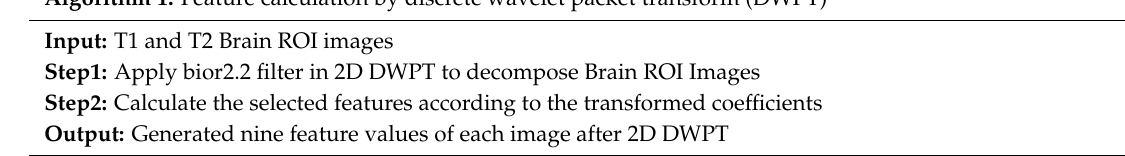
Algorithm 1. Feature calculation by discrete wavelet packet transform (DWPT) Input: T1 and T2 Brain ROI